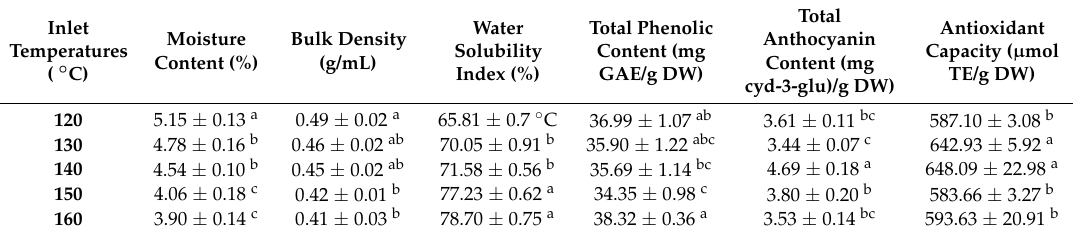
Table 2. Effects of spray-drying temperatures on physiochemical and antioxidant properties of instant mulberry juice